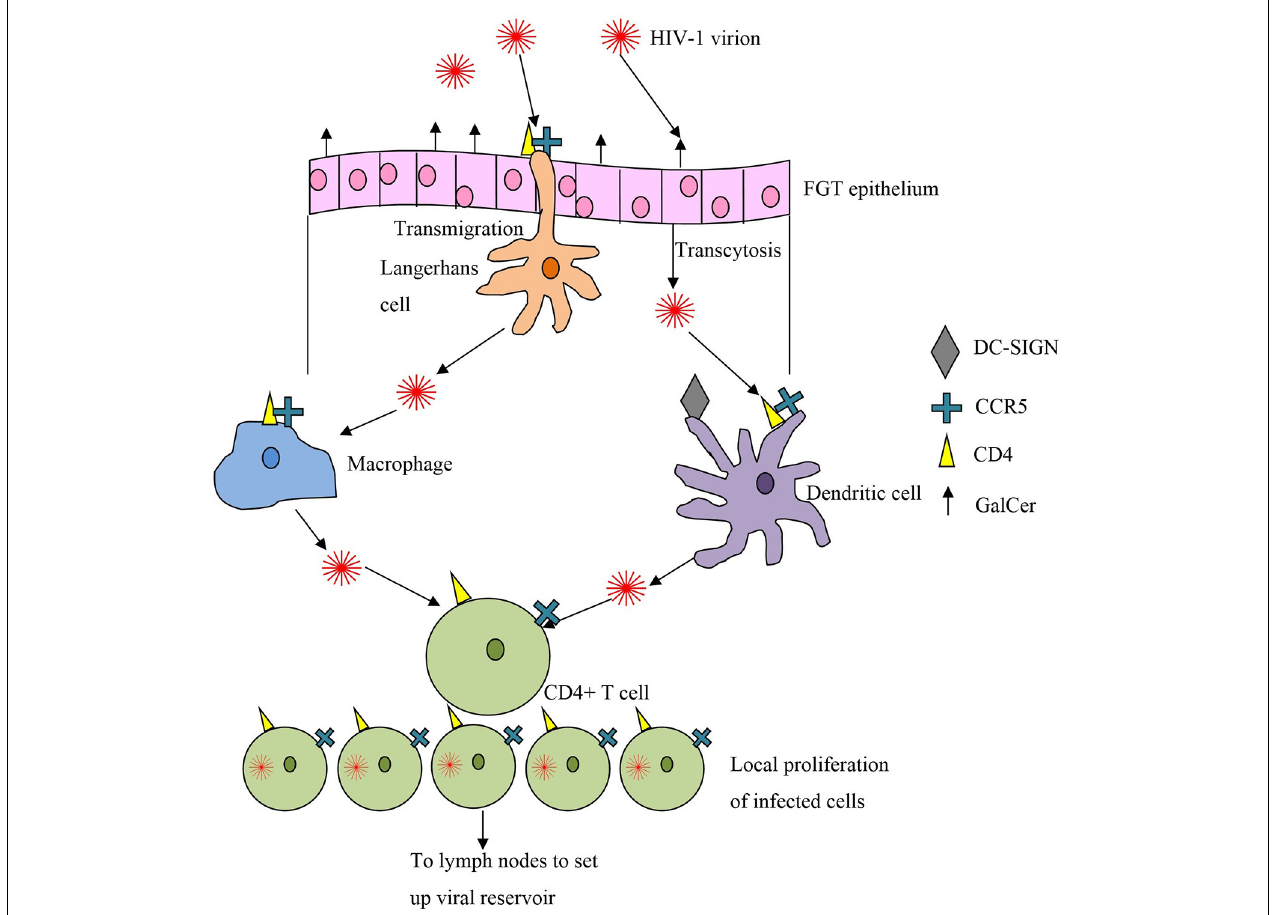
FIGURE 2 | Crossing the first line of defense, the epithelial mucosa, and targets of HIV infection.